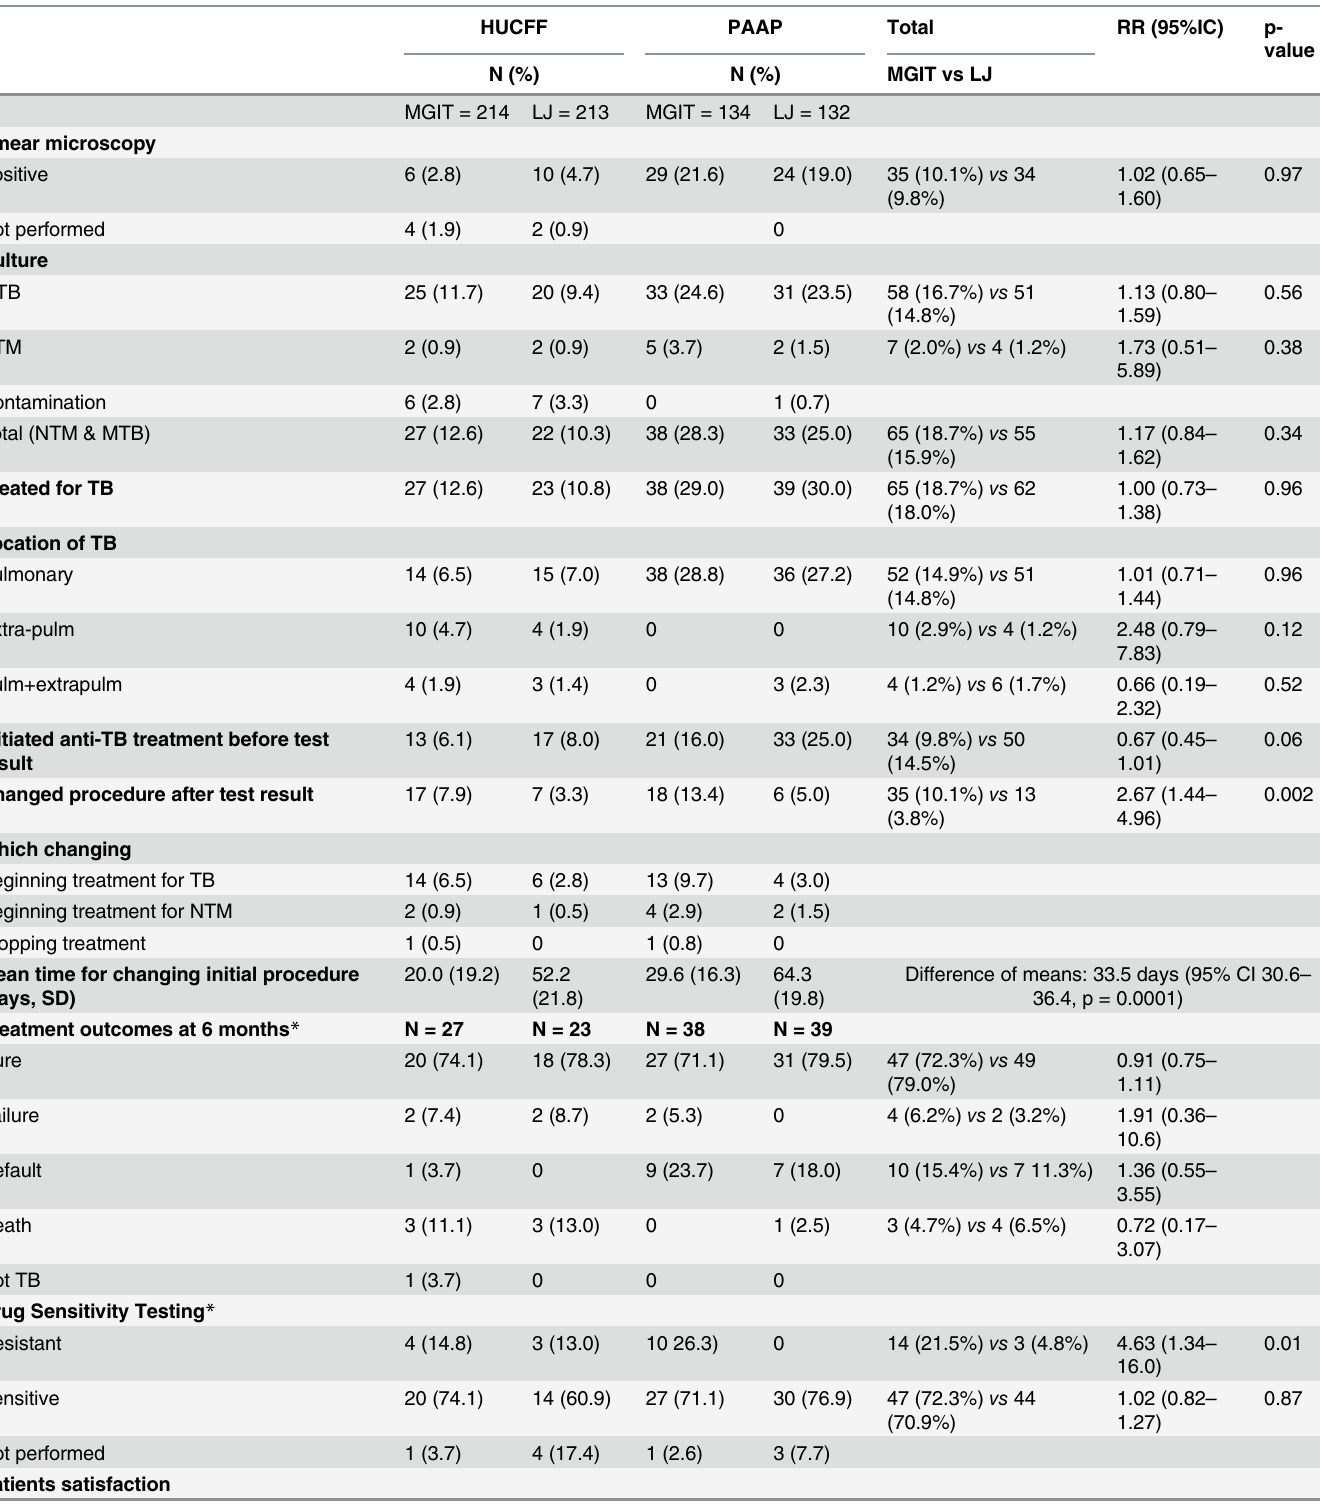
Table 2. Clinical and laboratory outcomes according to study group and health